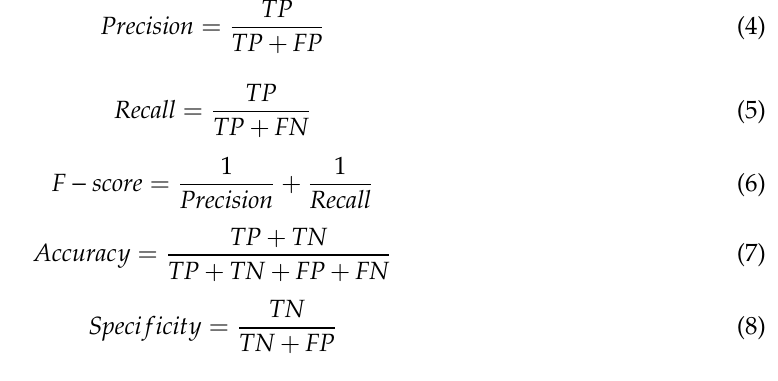
Table 2. Confusion matrix for evaluating model’s performance .